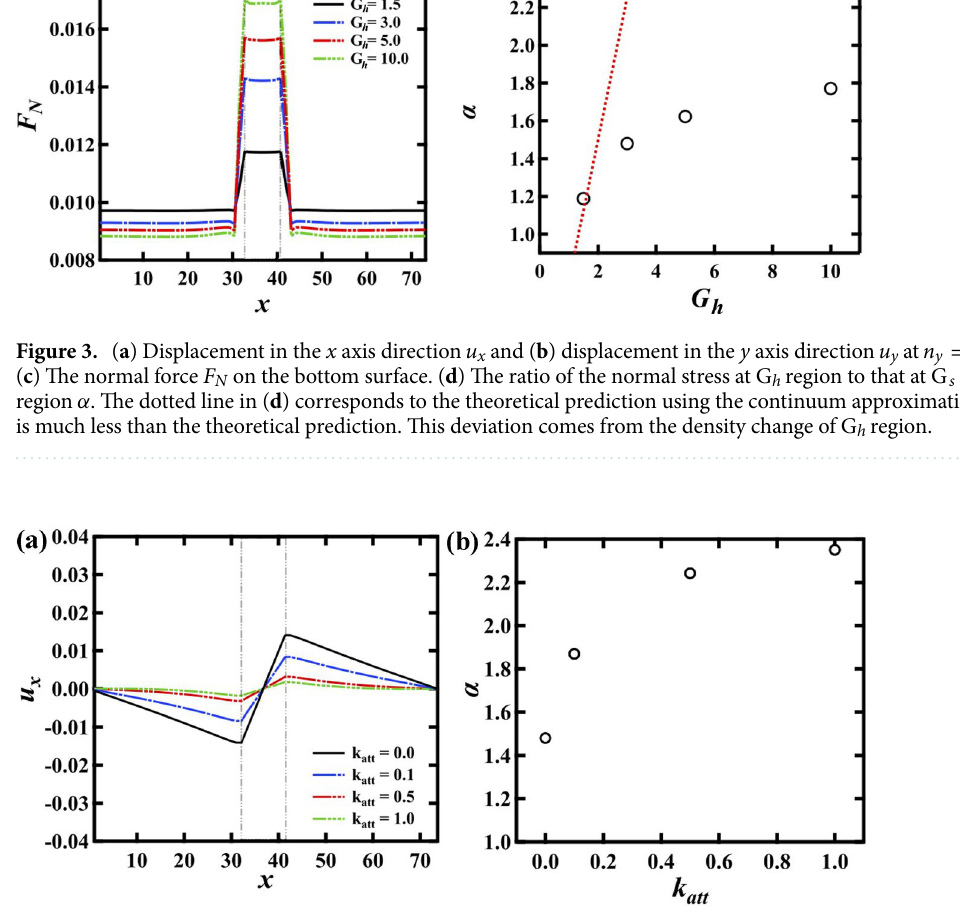
Figure 4. ( a ) Displacement in the x axis direction u x at n y = 12 with the attractive interaction systems. G h = 3 and W n = 8. ( b ) α as a function of k att . When the attractive interaction becomes stronger, u x becomes flat and then α becomes close to the theoretical